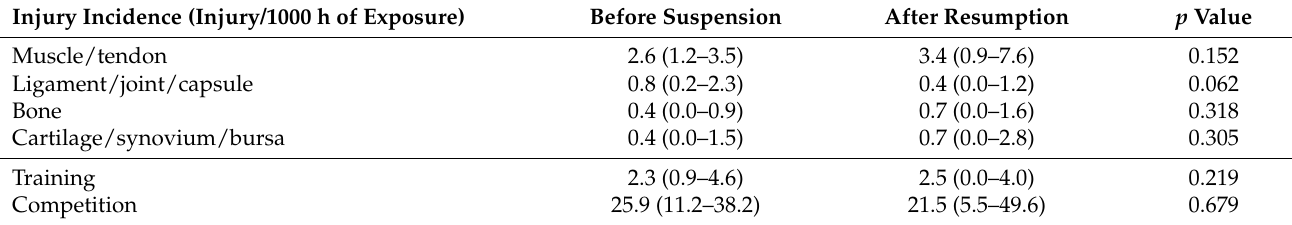
Table 1. Incidence of injuries shown according to tissue damage and time of injury (in training or during the match) in professional football players for the matchdays played before the suspension of LaLiga due to the COVID-19 pandemic and after the resumption of the competition.